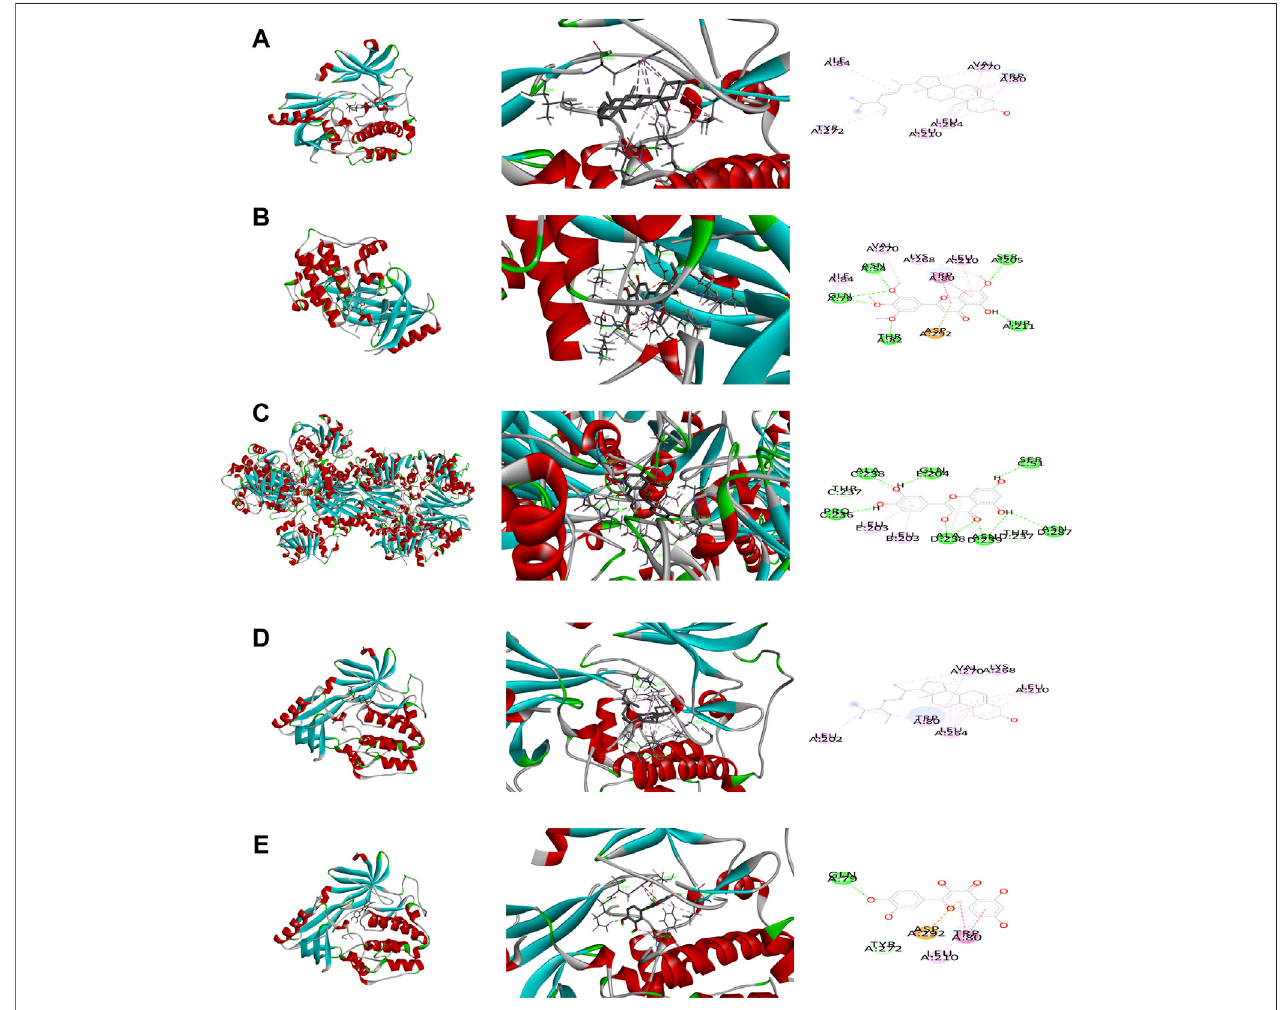
FIGURE 4 | Binding studies of selected ingredients – targets interactions. (A) AKT with Stigmasterol; (B) AKT1 with Corymbosin; (C) GAPDH with quercetin; (D) AKT1 with beta-sitosterol; (E) AKT1 with quercetin.